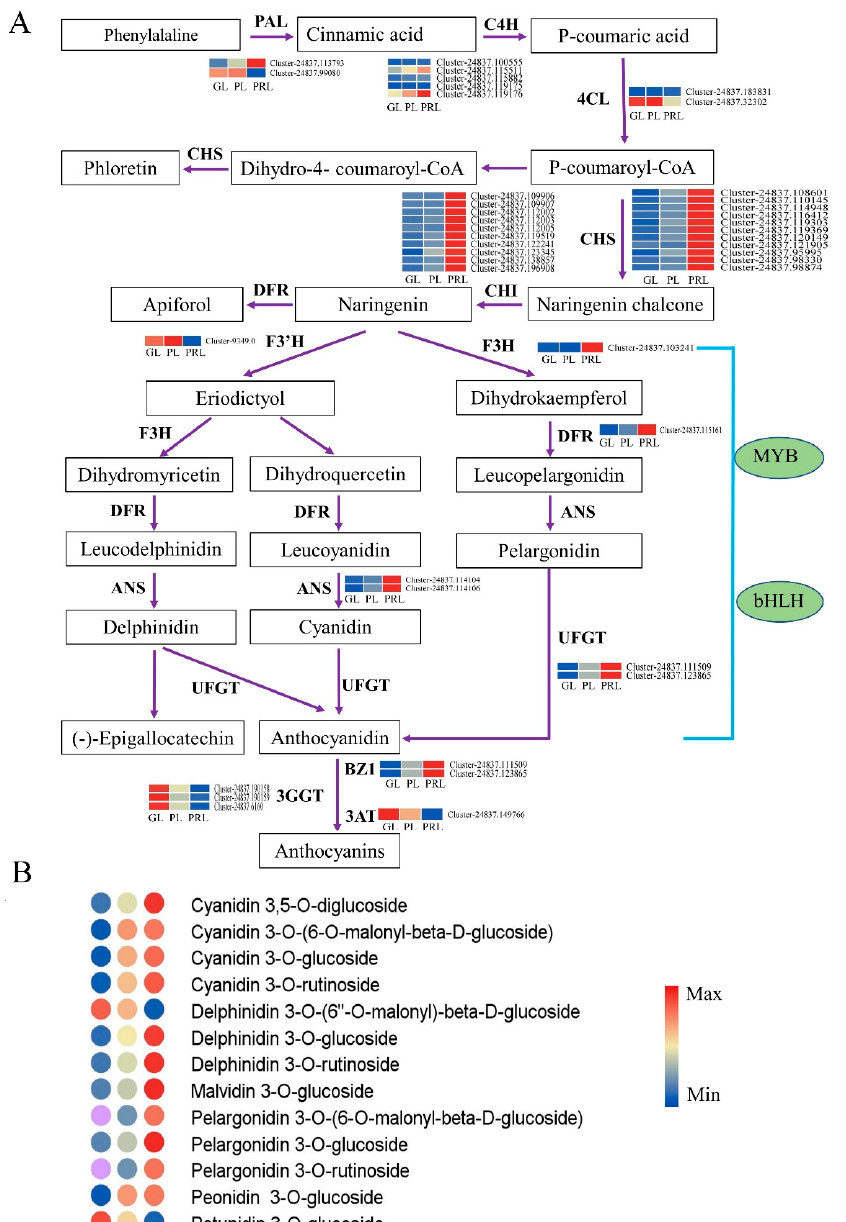
Figure 6. The expression of genes in the phenylpropanoid and flavonoid biosynthetic pathways in P. virginiana leaf. ( A ) Reconstruction of the anthocyanins biosynthetic pathway with the differentially expressed structural genes and their regulators. The differentially expressed genes (DEGs) were identified by an adjusted p -value < 0.05 and |log 2 fold change (FC)| ≥ 1. ( B ) The differentially accumulated metabolites (DAMs) in the anthocyanin biosynthetic pathway. The DAMs were iden- tified by projection (VIP) values (VIP ≥ 1) and fold change ≥ 2 or ≤ 0.5. The color scale from Min (blue) to Max (red) refer to the metabolite contents from low to high. The cluster marker on the right side of heatmap represents the names of each gene. GL, green leaf; PL, purple leaf; PRL, purple-red leaf; PAL, phenylalanine ammonia-lyase; C4H, cinnamic acid 4-hydroxylase; 4CL, 4-coumarate CoA ligase; CHS, chalcone synthase; CHI, chalcone isomerase; DFR, dihydroflavonol 4-reductase; F3H, lavanone 3-hydroxylase; F3 (cid:48) H, lavonoid 3 (cid:48) -hydroxylase; ANS, anthocyanidin synthase; UFGT, UDP glucose-flavonoid 3-O-glcosyl-transferase; BZ1, anthocyanidin 3-O-glucosyltransferase; 3GGT, 3-O-glucoside 2”-O-glucosyltransferase; 3AT, 3-O-glucoside-6”-O-malonyltransferase; MYB, v-myb avian myeloblastosis viral oncogene homolog; bHLH, basic